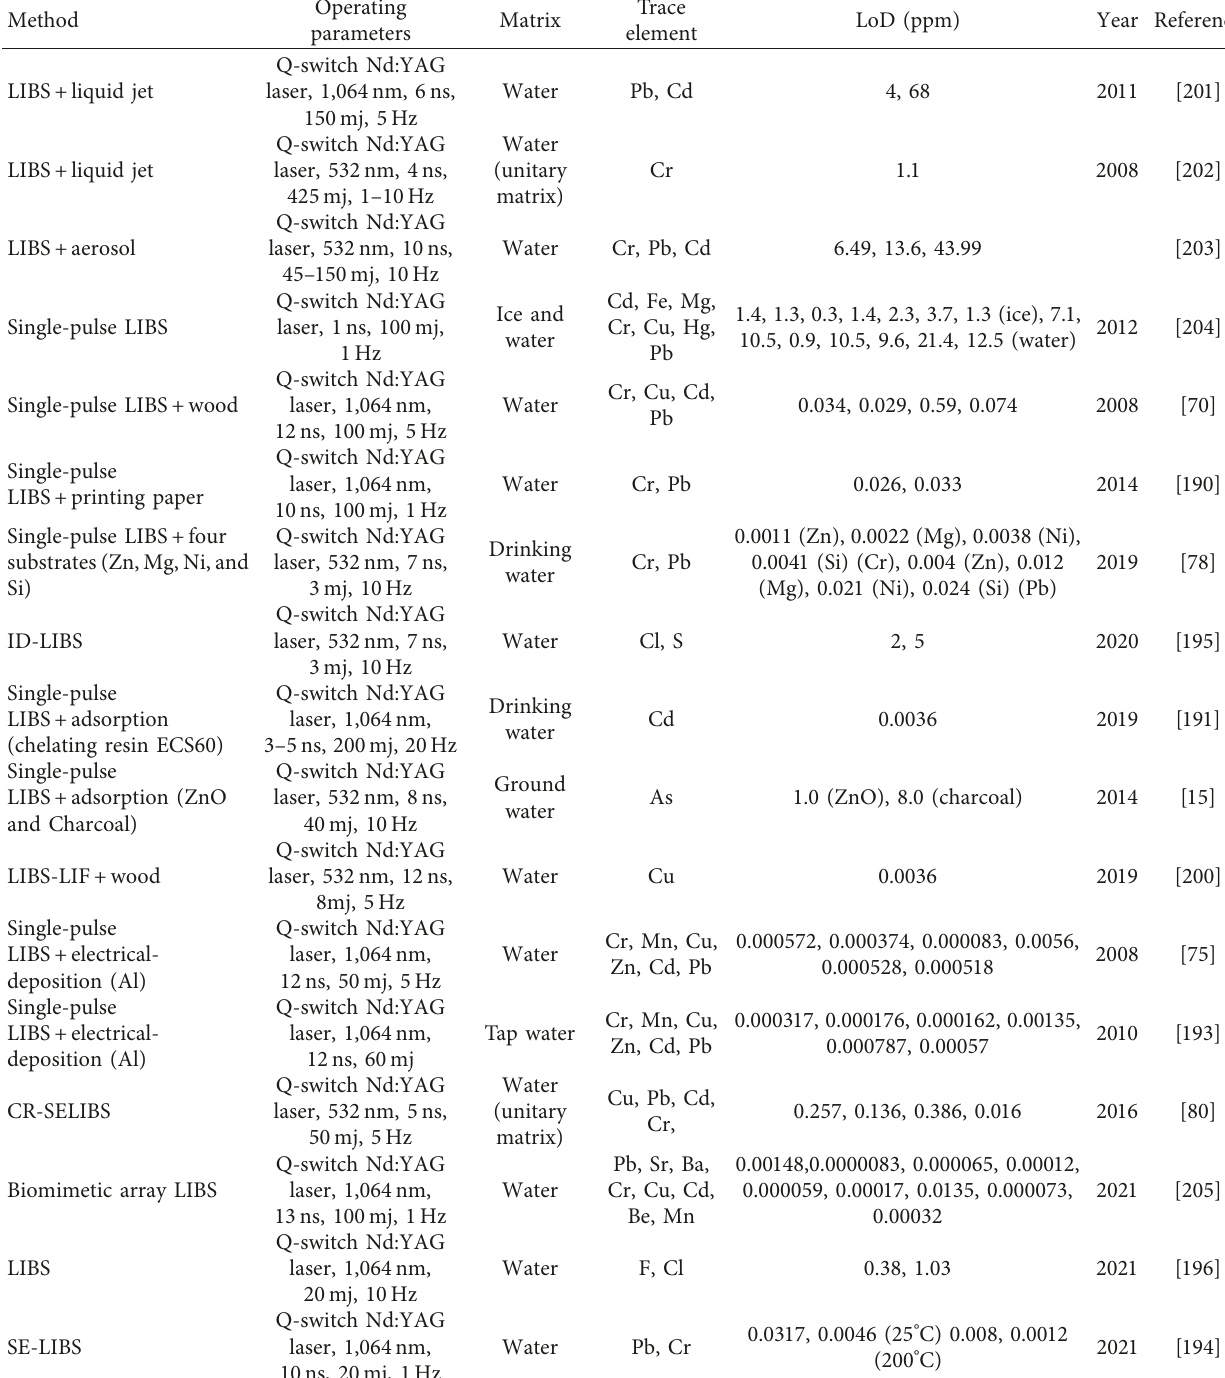
Table 5: LIBS characterization of the trace elements in drinking